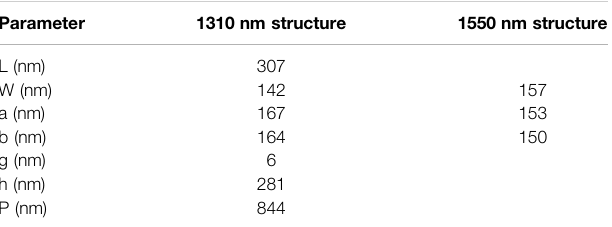
TABLE 1 | Comparison of parameters of 1310 nm structure and 1550 nm structure. Parameter